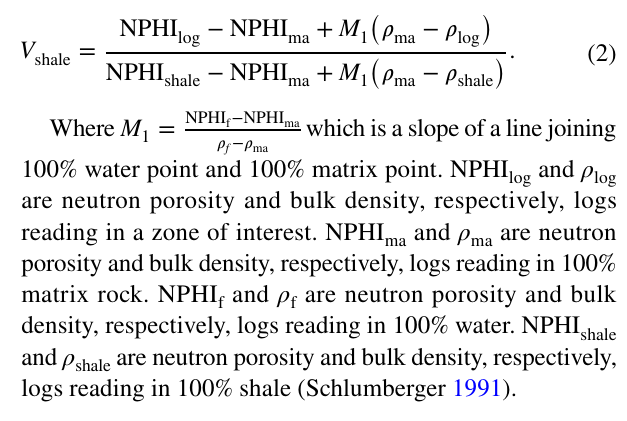
Table 5 Statistics of effective porosity and water saturation